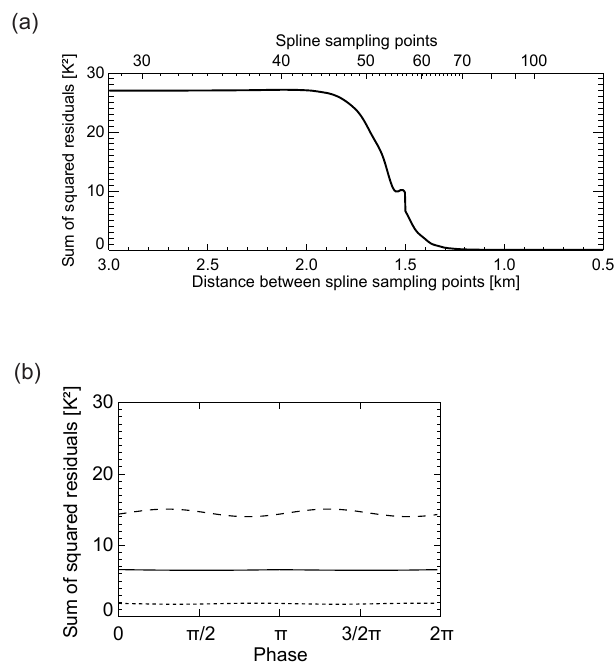
Figure 6. Part (a) is equivalent to Fig. 3, part (b) is equivalent to Fig. 4, but here the repeating spline approach is